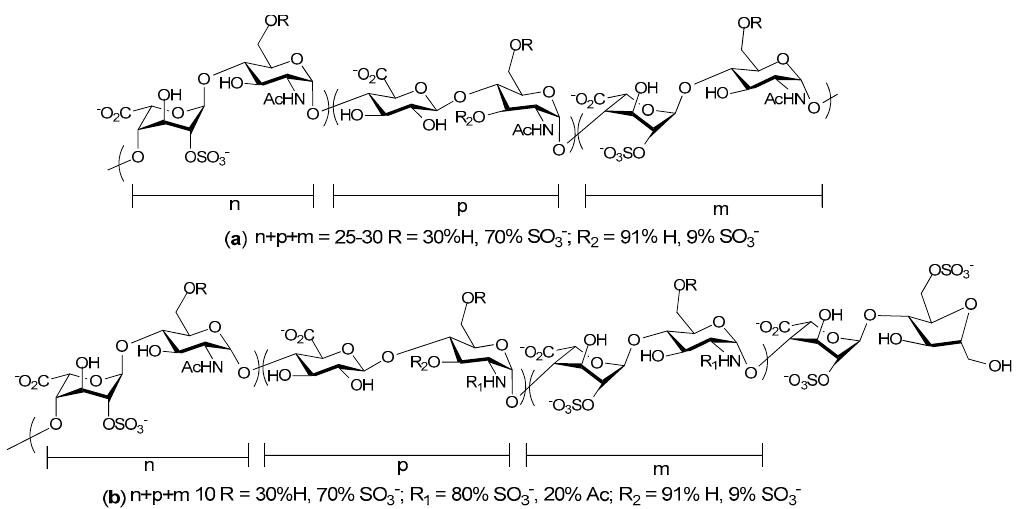
Figure 7. Schematic representation of ( a ) SST0001 (roneoparstat) ( b ) M402 (necuparanib). The actual structures may retain the microheterogeneity of the original heparin and low-molecular-weight-heparin (LMWH) [89].